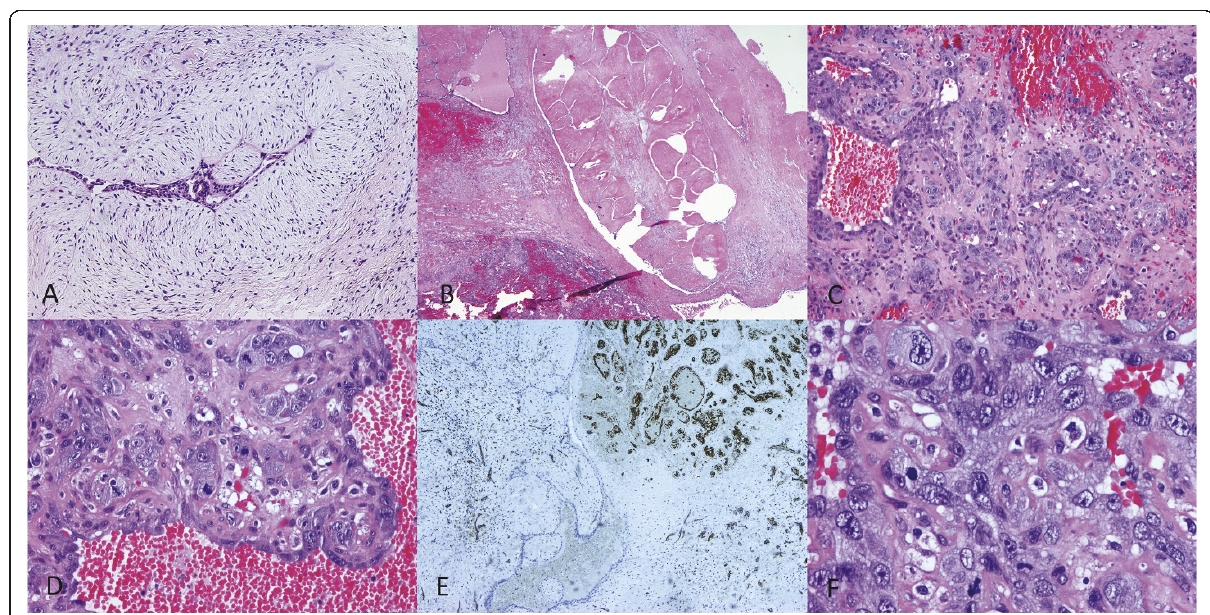
Figure 2 Microscopic features of the resected tumor . Fibroadenoma of the breast HE, 100 × (A). Fibroadenoma and angiosarcoma in the same field, HE, 20 × (B). Angiosarcoma, the tumor is highly vascular with relatively solid spindle cell proliferation and area of stromal hemorrhage, HE, 100 × (C). Prominent tufts and papilations composed of enlarged highly malignant endothelial cells with brisk mitotic activity, HE, 200 × (D). Immunohistochemical stain for vascular marker CD34 was positive in angiosarcoma and negative in fibroadenoma, 40 × (E). Highly malignant endothelial cells, HE, 400 × (F).